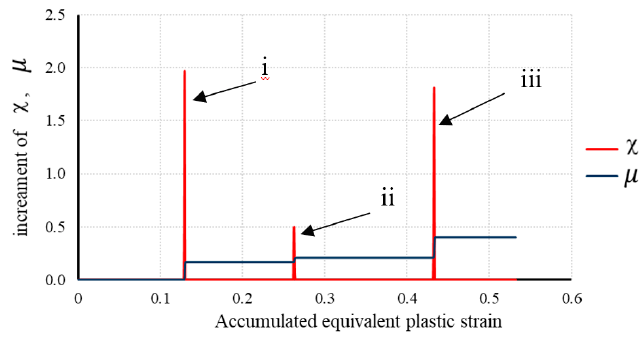
Figure 5. An example of the evolution of the two non-proportional parameters χ and µ during cyclic loading. This is an experimental example of the “R1” specimen under extremely low-cycle fatigue (ELCF) with N f = 4.